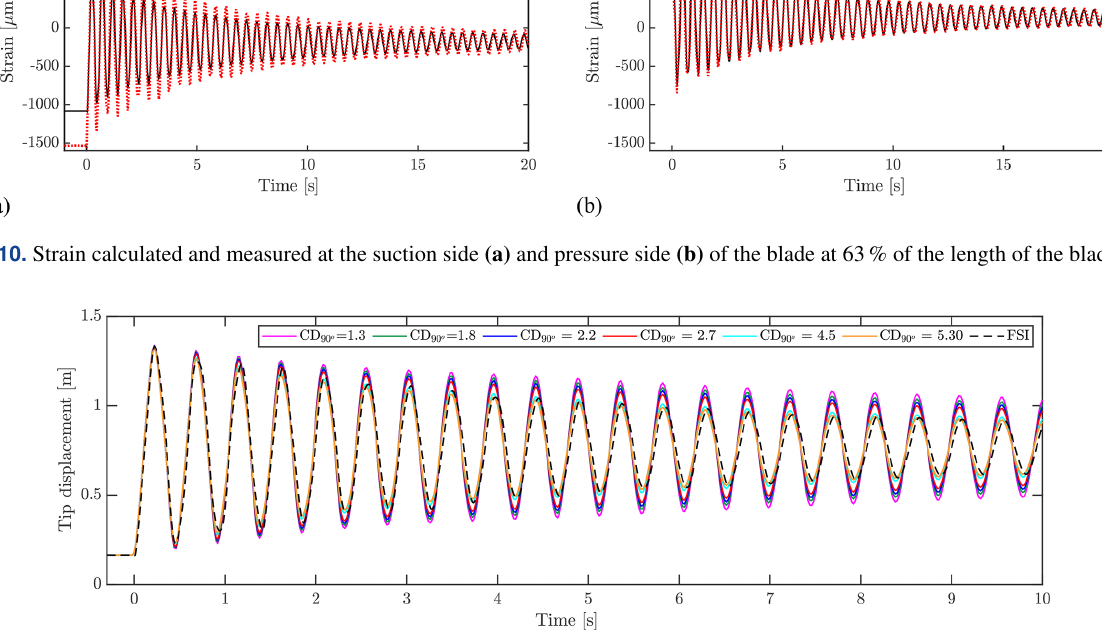
Figure 11. Tip displacement using BET aerodynamics with different drag coefficients compared with FSI results. All simulations have an initial tip displacement of